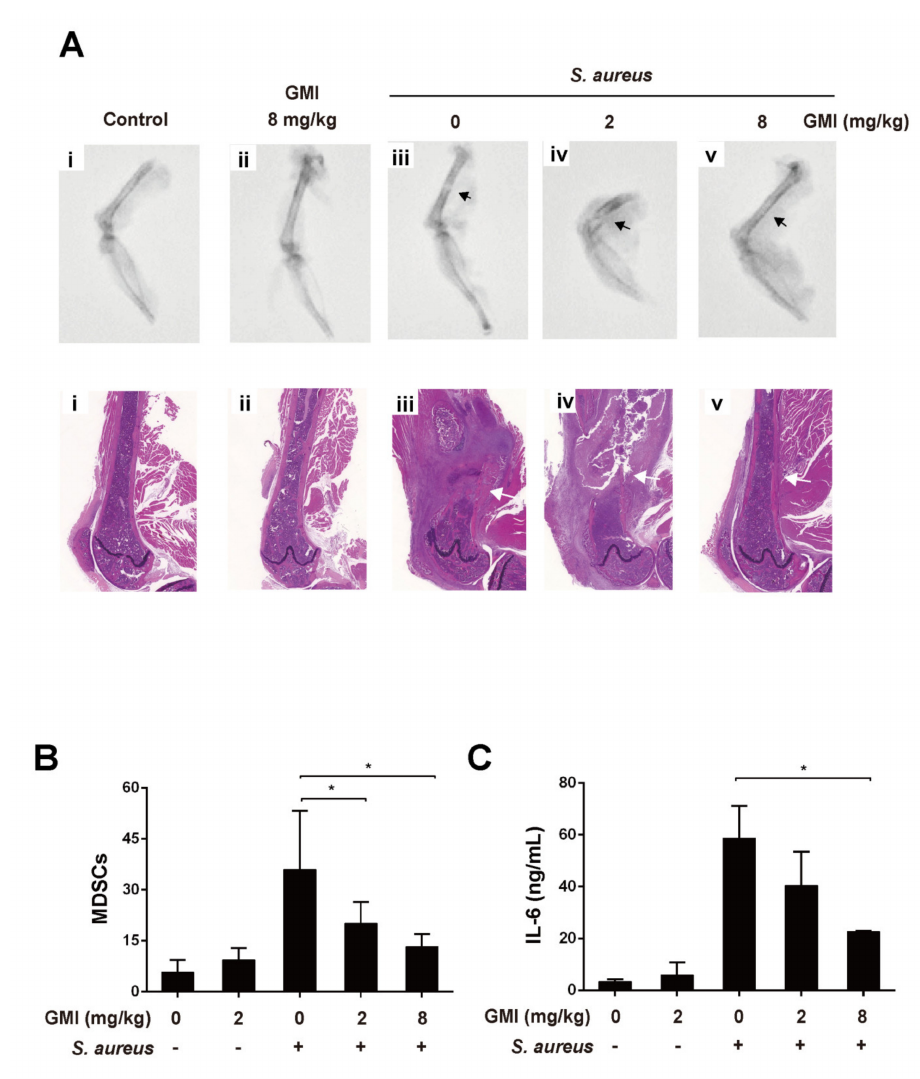
Figure 6. Influence of GMI treatment on S. aureus infection in a mouse PJI model. Mice were divided into five groups ( n = 4): (i) control group (ii) GMI (8 mg/kg) only; (iii) infected with S. aureus only; (iv,v) infected with S. aureus and injecting 2 and 8 mg/kg GMI. ( A ) X-ray images (upper) and histological staining (lower) of femur in mice infected with S. aureus are shown. Black arrow indicates S. aureus infection site and bone destruction; White arrow showed infiltrating mononuclear immune cells. ( B ) MDSCs in PBMCs were enumerated by flow cytometry. ( C ) The concentration of IL-6 in GMI-treated mice that were uninfected or infected with S. aureus was determined using a CBA kit. The results were analyzed statistically with Student’s t -test. *: p <